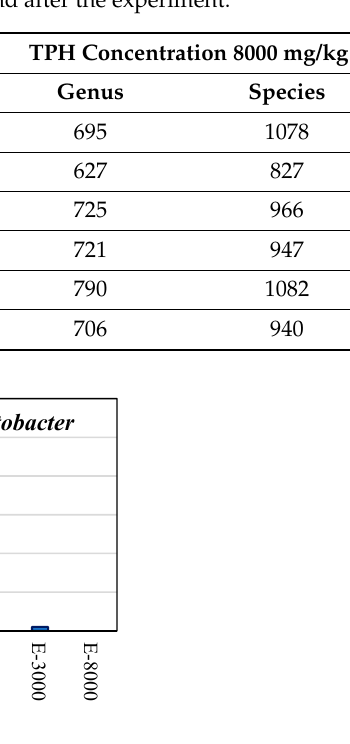
Figure 3. Changes of bacterial phases in different bioremediation test groups. ( a ) for TPH conc. 3000 mg/kg; ( b ) for TPH conc. 8000 mg/kg. Table 1. Changes in soil bacterial phase abundance before and after the experiment.